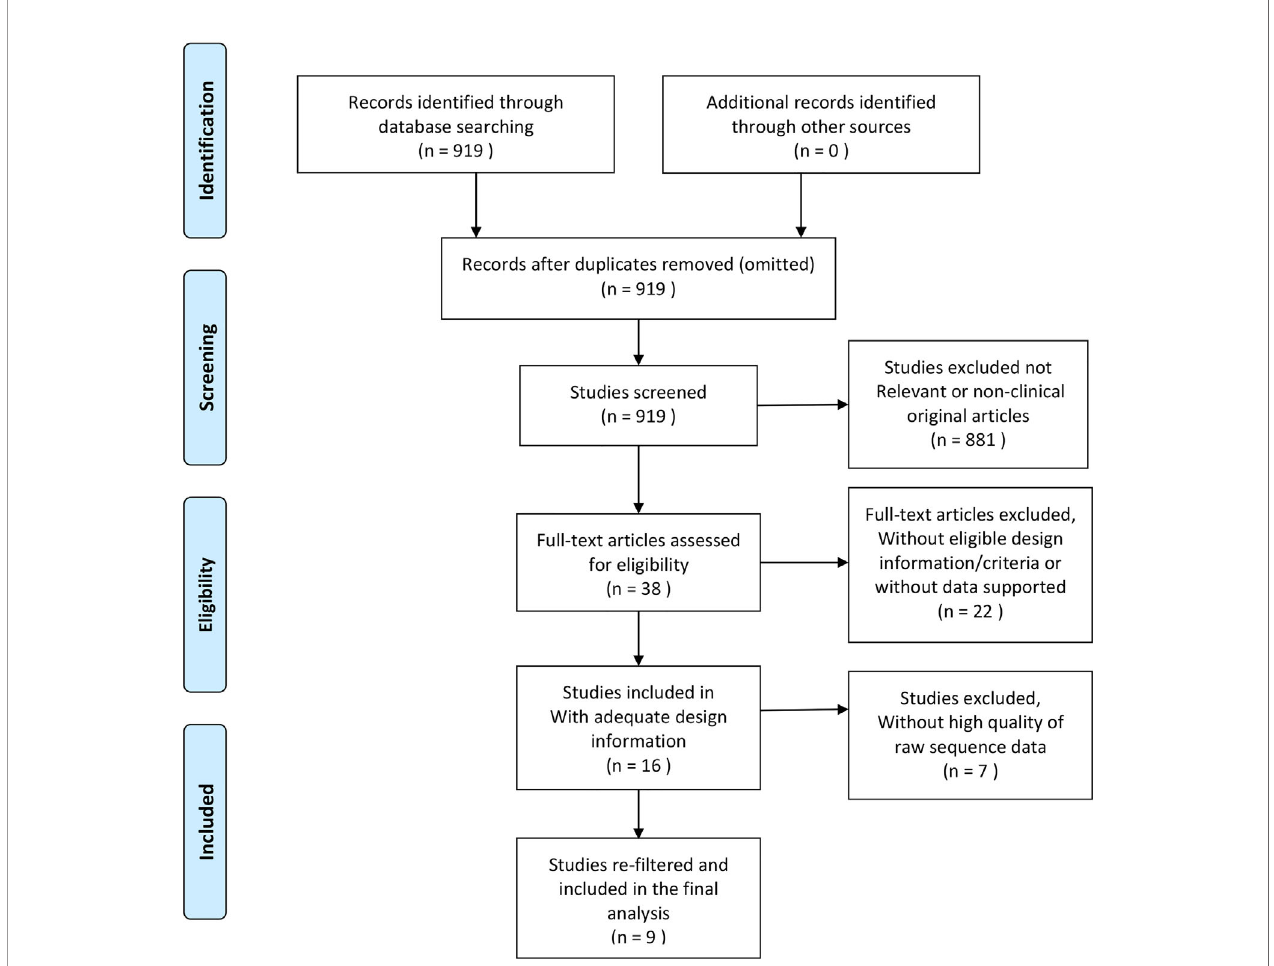
FIGURE 1 | Modi fi ed fl ow diagram of collecting and screening articles, processing, and re- fi ltering